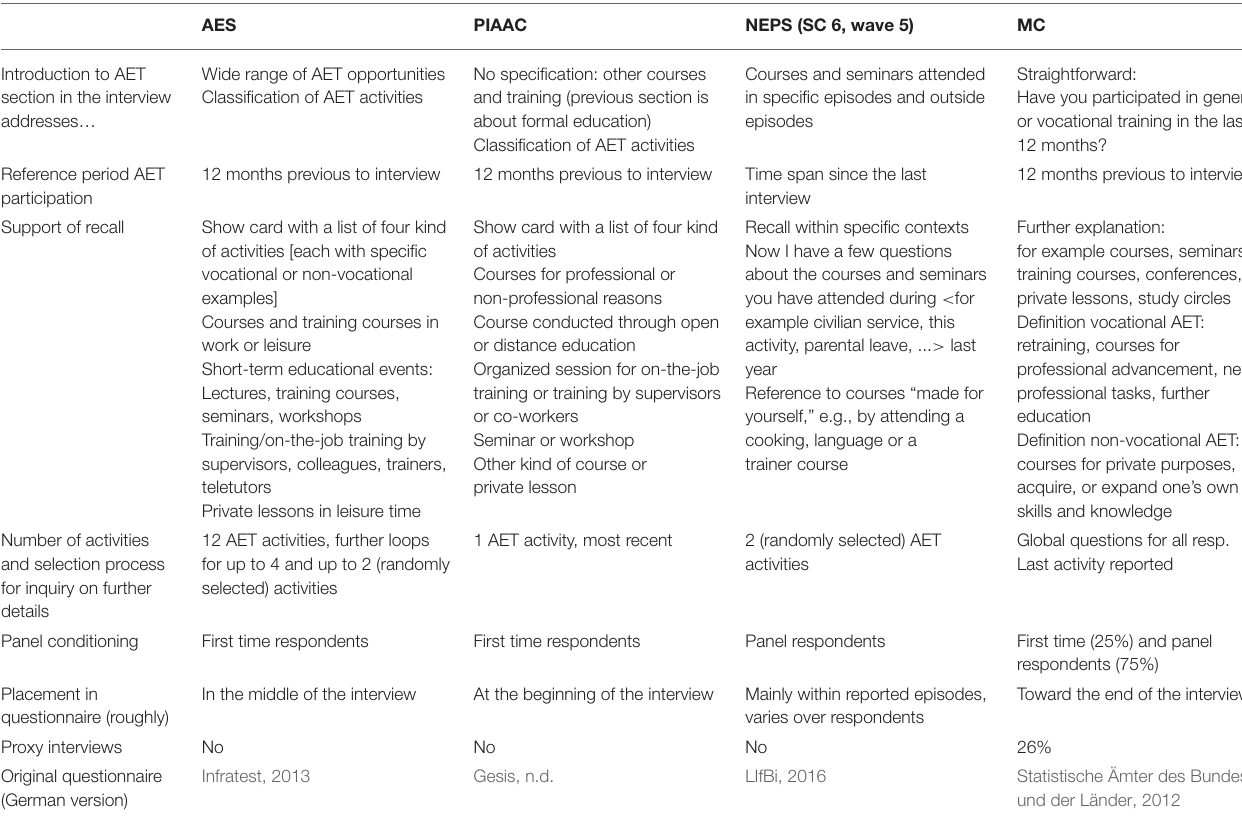
TABLE 2 | Overview of measurement of AET in the AES, PIAAC, NEPS, and